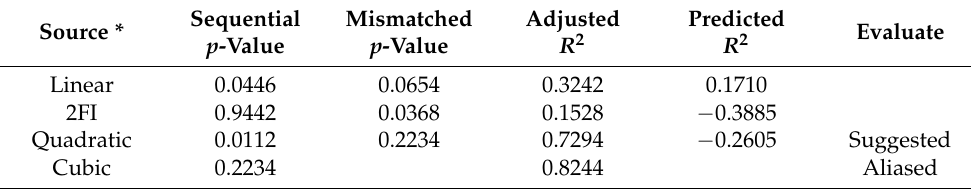
Table 6. Comprehensive analysis of various models of slump.